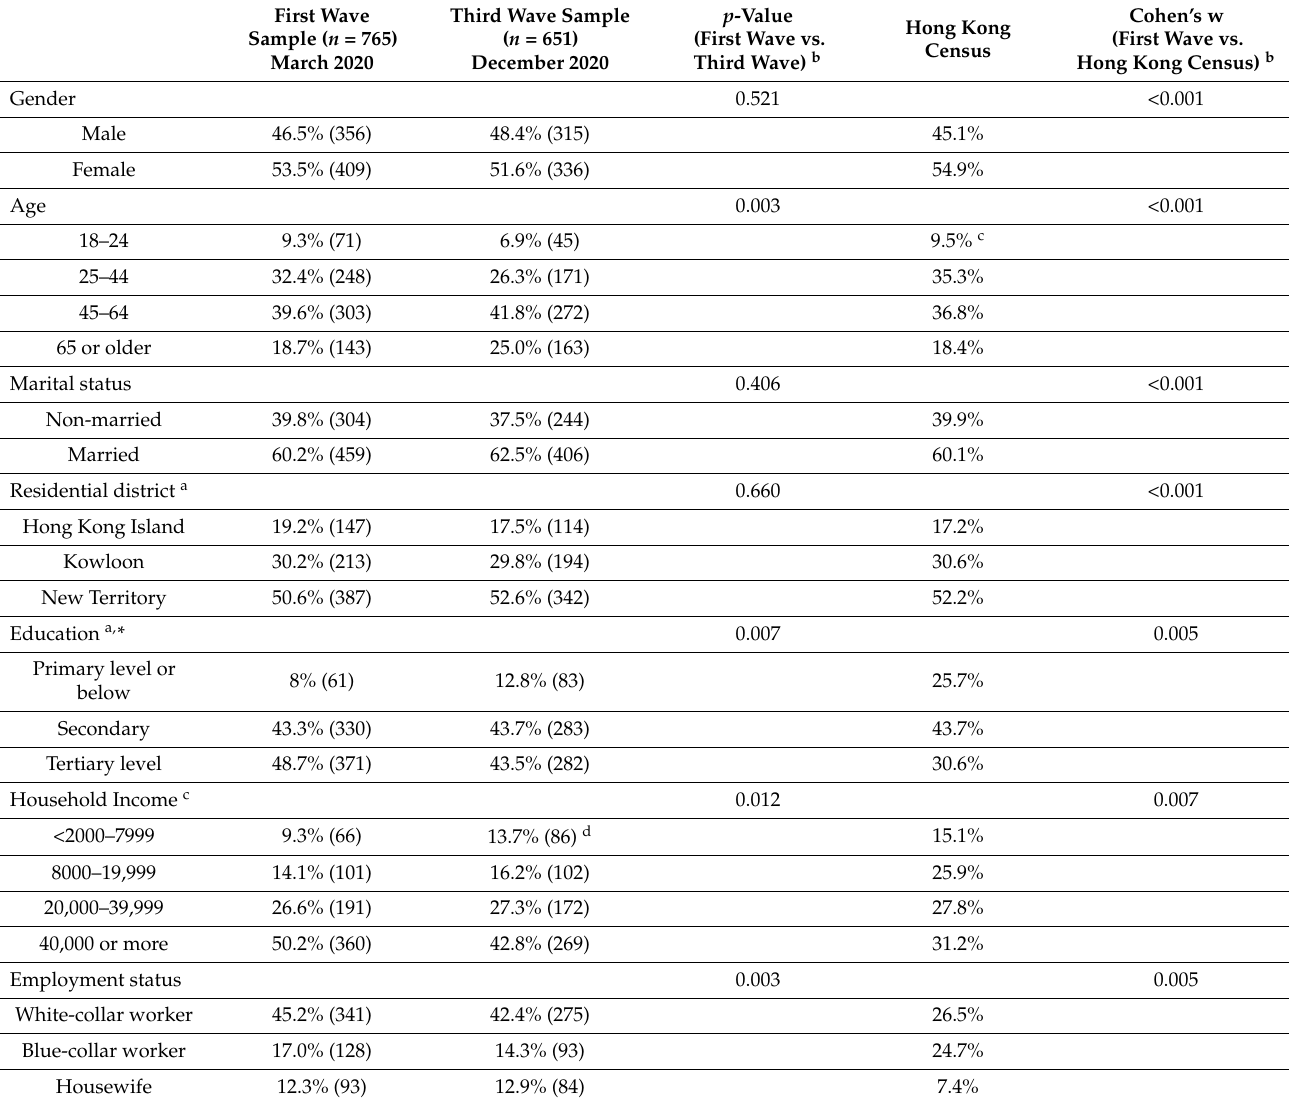
Figure 1. Hong Kong COVID-19 pandemic waves (2020–2021) with daily caseloads, government pandemic responses and timing of the serial cross-sectional studies. Table 1. Background characteristics of study sample and general pandemic perceptions.